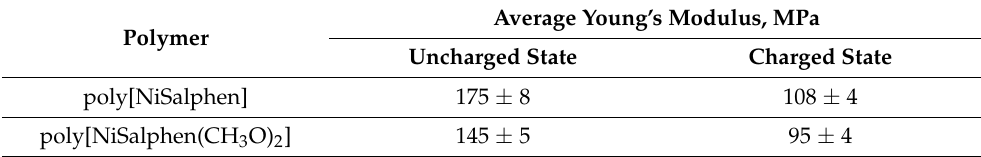
Table 2. Average Young’s modulus of polymer films in uncharged and charged states in 0.1 M Et 4 NBF 4